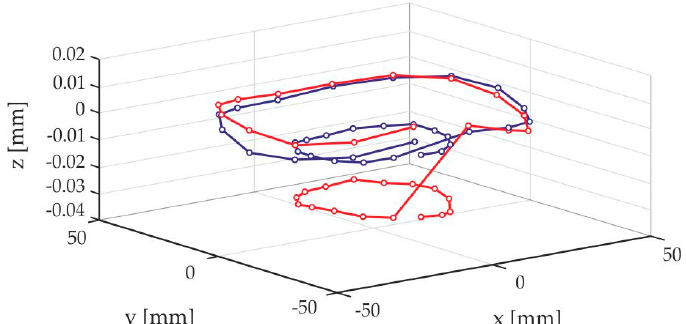
Figure 8. Example of experimental surface flatness results for measuring points (see Figure 1) for reference elements (blue color—before heat treatment processing, red color—after heat treatment processing).